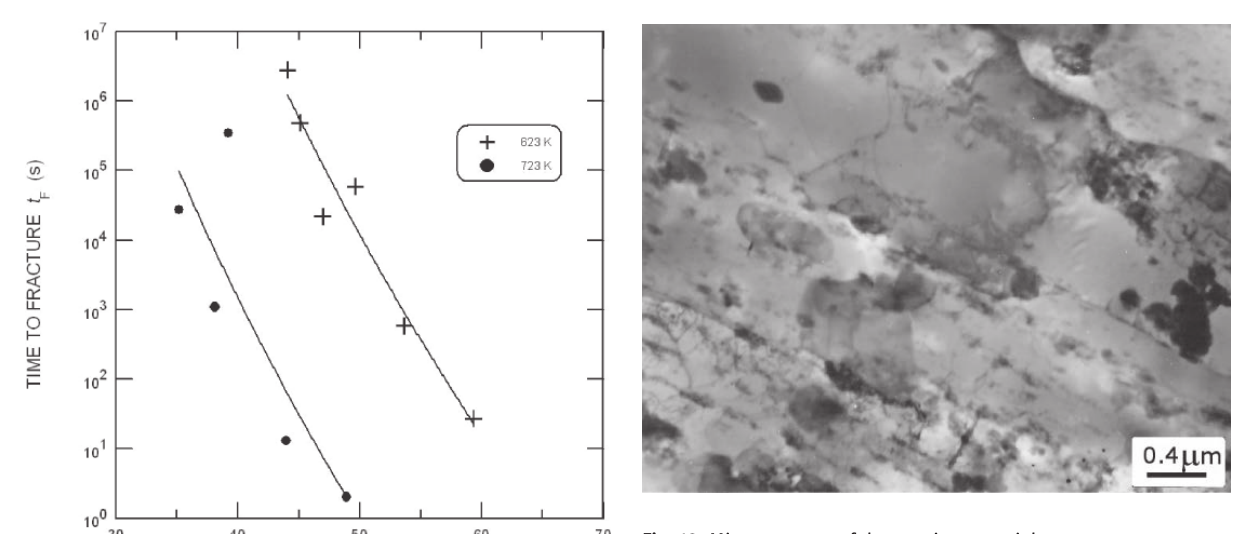
Fig. 19: Microstructure of the starting